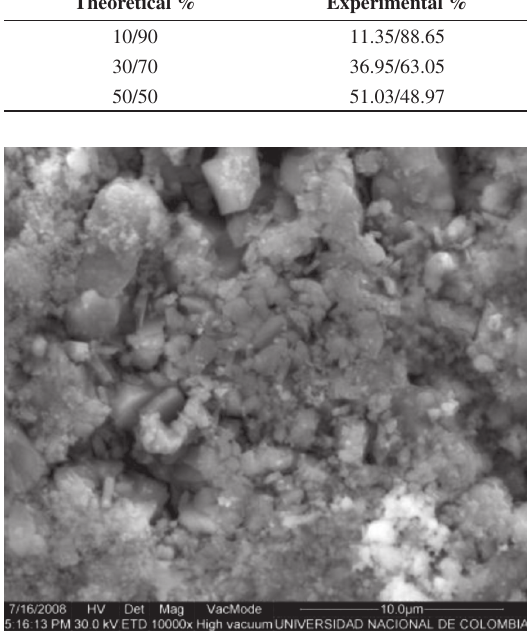
Figure 3. SEM micrograph for the 50/50 YBCO/BZO composite. YBCO are the particles with size varying from 1 to 4 µ m, and the BZO particles are of the order sub-micrometer 14 .